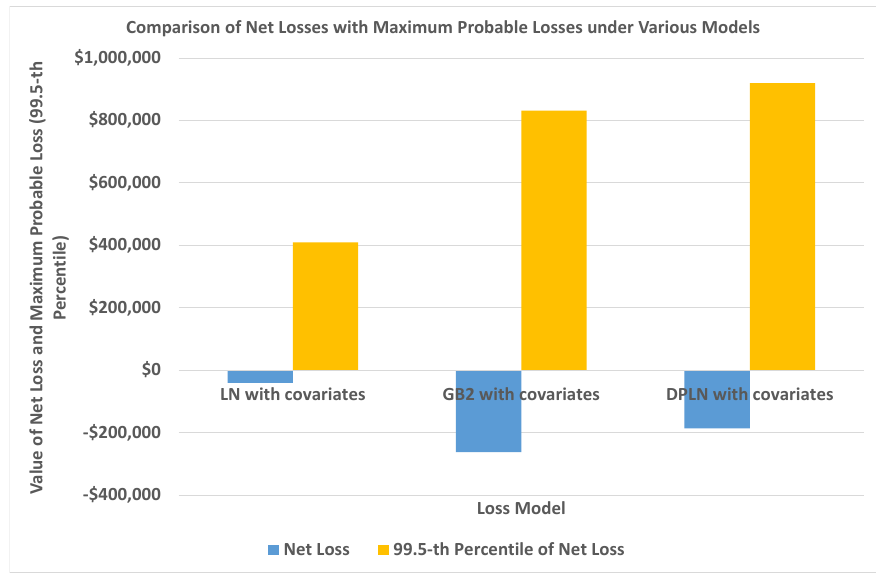
Figure 5. Probability-probability plots of upper tail (out-of-sample).